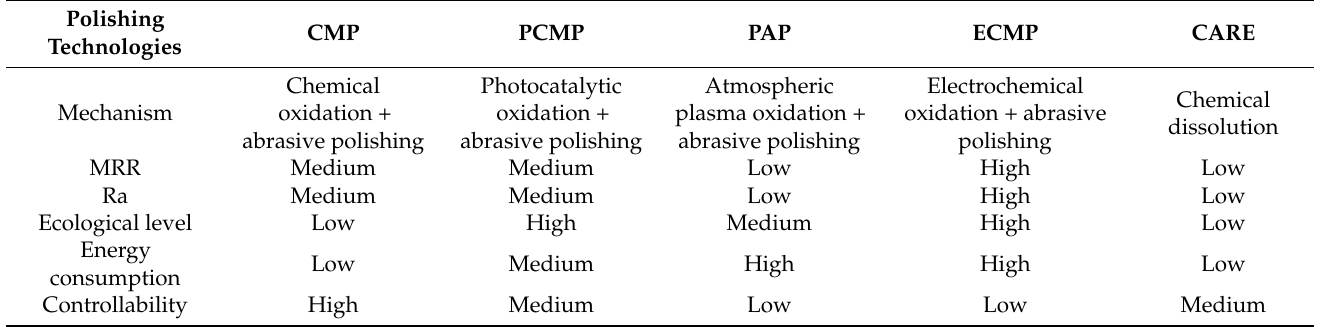
Table 3. Comparison of different polishing technologies for single-crystal SiC.